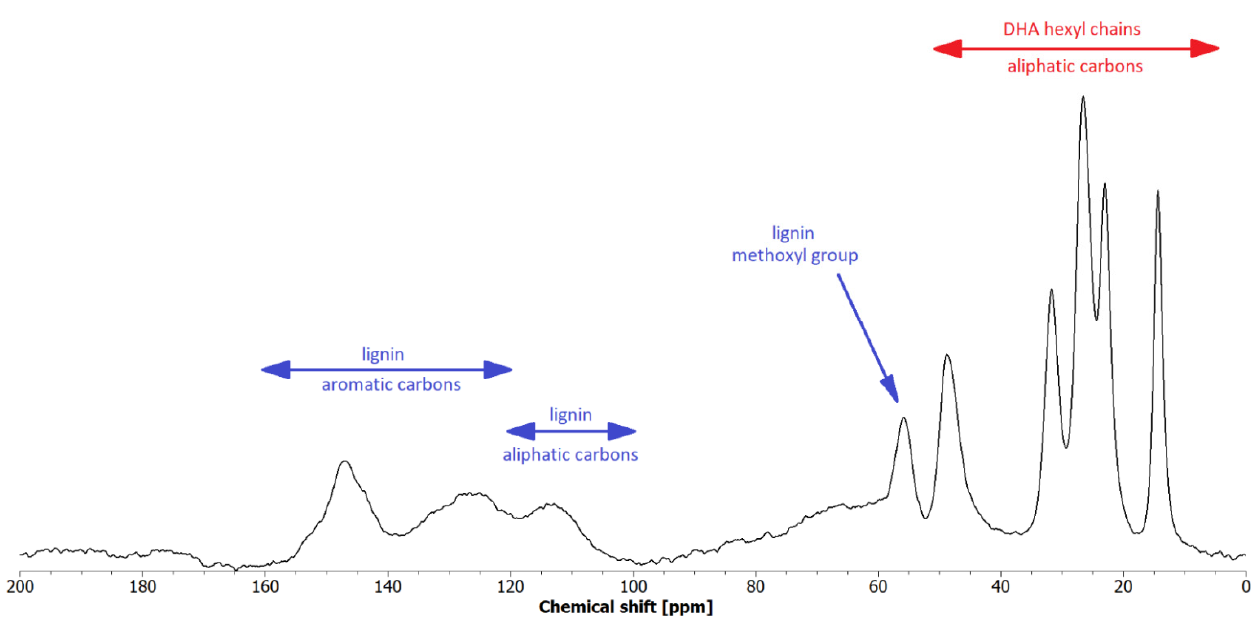
Figure 4. Solid-State 13 C NMR spectrum of the ligH-HSO 3 Cl-DHA-HW sample.